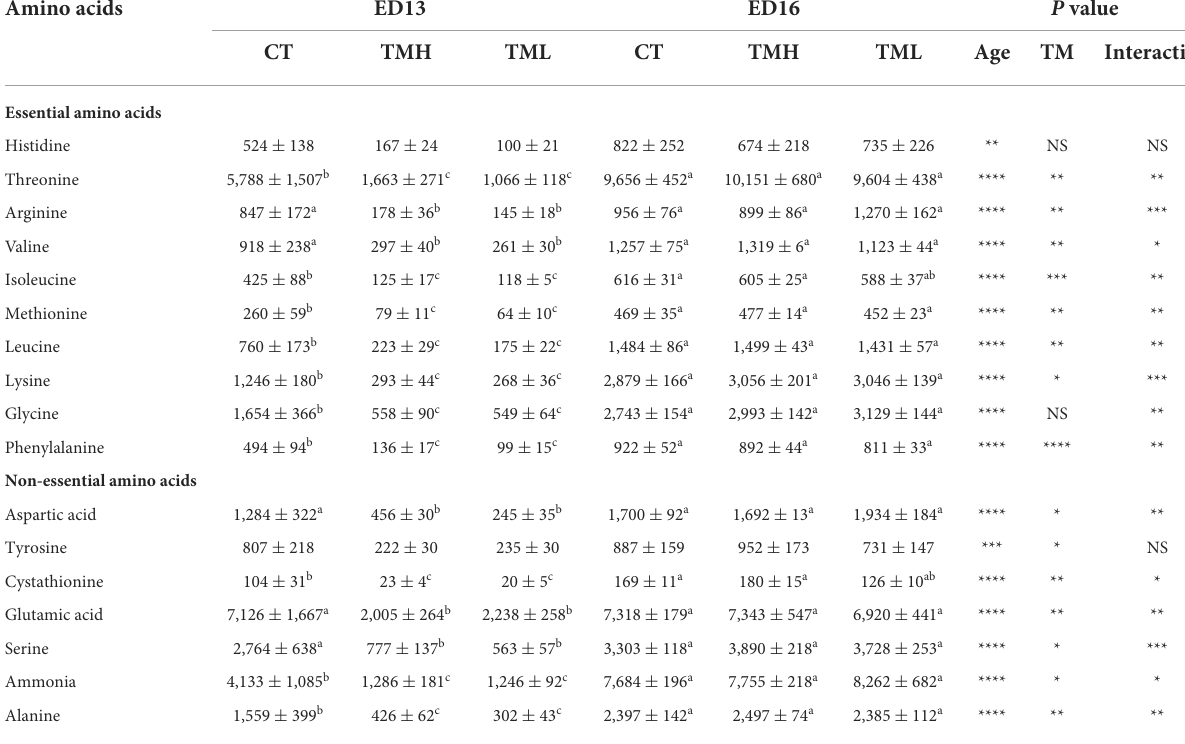
TABLE 1 Free amino acid contents in the liver of embryos exposed to control or modified temperature during embryogenesis. Amino acids ED13 ED16 CT